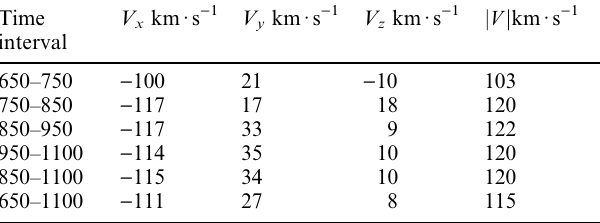
Table 1. Components of plasma bulk